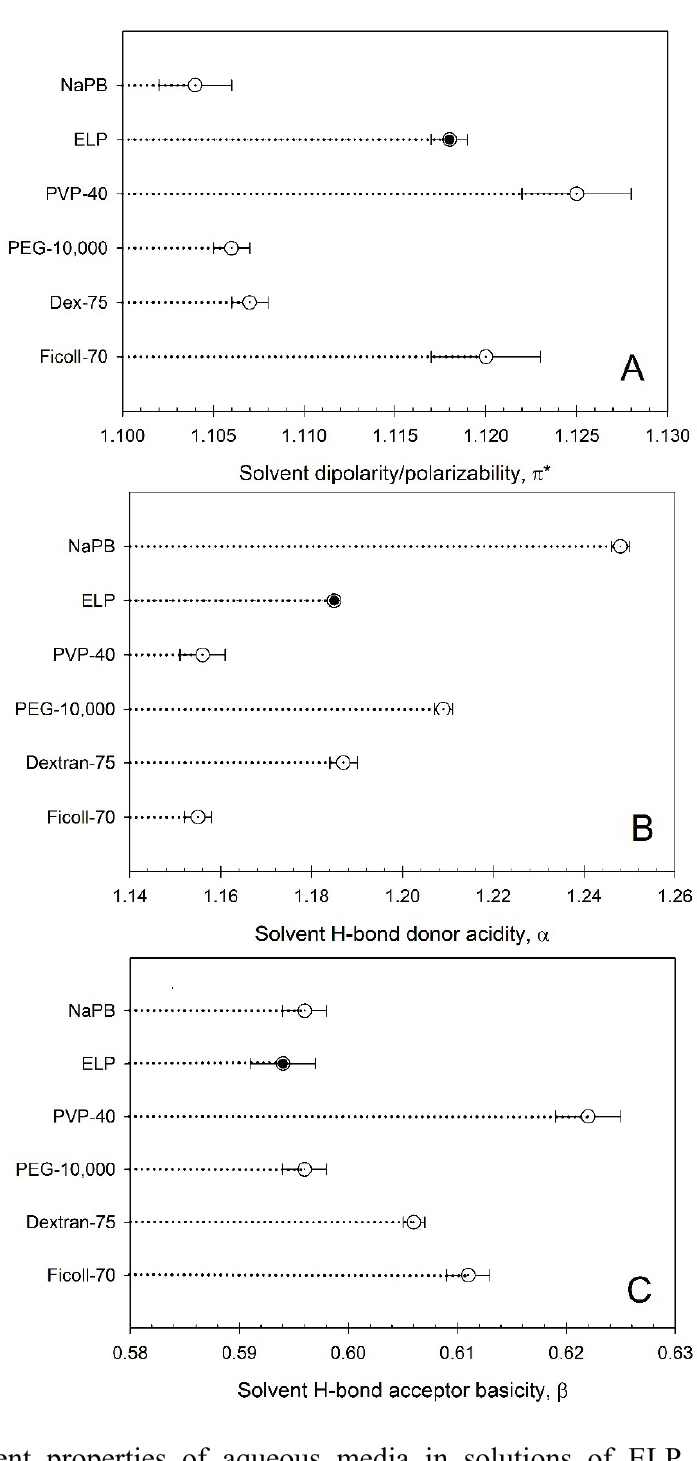
Figure 4. Solvent properties of aqueous media in solutions of ELP (GVGVP) 40 and nonionic polymers at a 0.90 mM concentration in an aqueous 0.01 M sodium phosphate buffer (NaPB) pH 7.4: ( A ) dipolarity/polarizability π *; ( B ) H-bond donor acidity α ; and ( C ) H-bond acceptor basicity β . Ficoll-70—Ficoll with a weight-averaged molecular mass of M W ~ 70,000; dextran-75—dextran with M W ~ 75,000; PEG-10,000—polyethylene glycol with M W ~ 10,000; PVP-40—polyvinylpyrrolidone with M W ~ 40,000; and NaPB—0.01 M sodium phosphate buffer, pH